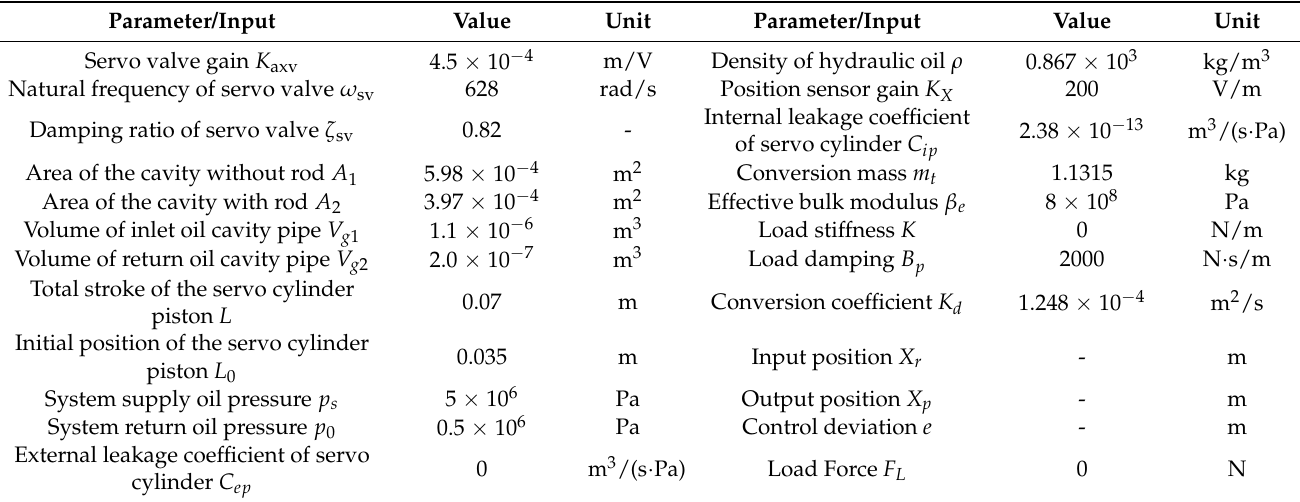
Table 1. Parameters definition and simulation values of HDU position control